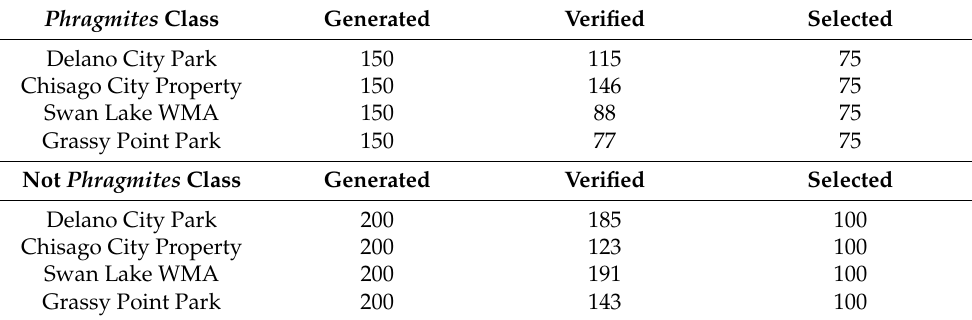
Table 9. Validation points per cover class for each validation site. The total number of points randomly generated, the number manually verified through image interpretation, and the number selected from the verified points are